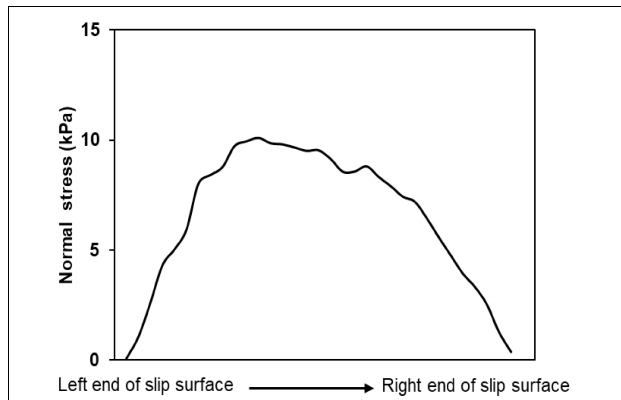
FIGURE 13 | Variation of the normal stress at the bottom of failure mass along the slip surface.